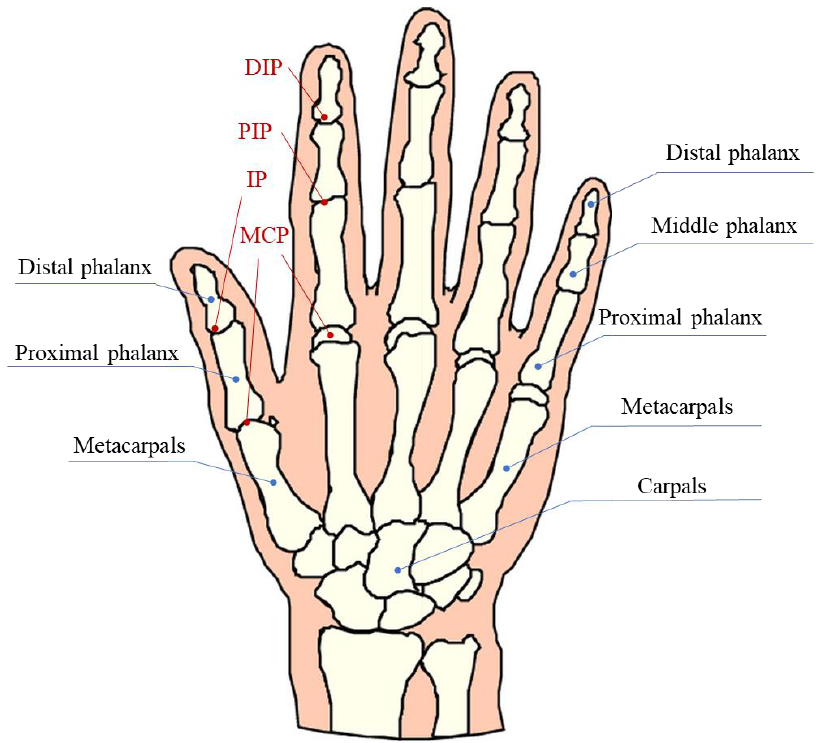
Figure 1. Physiological structure of the human hand [33].